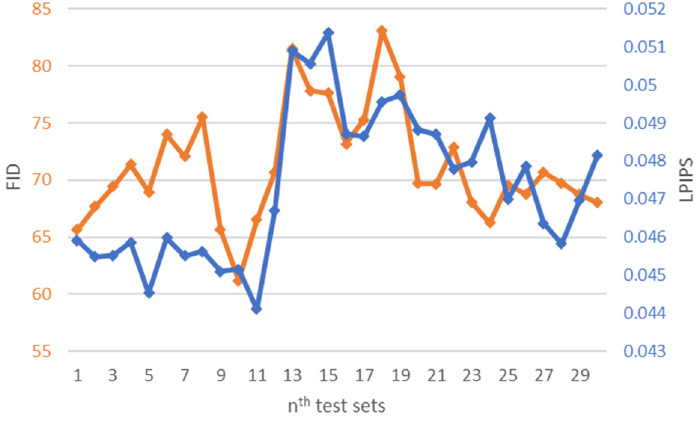
Figure 18. FID and LPIPS metrics of the synthetic COVID-19 CT images generated by sRD-GAN on the 30 test sets from the HUST-19 dataset [4]. Synthetic samples are included in Dataset S3.